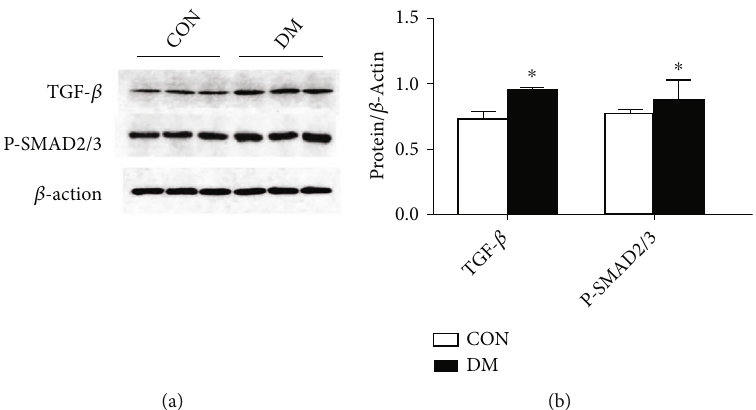
Figure 5: Expression of TGF- β and P-SMAD2/3 was analyzed by Western blots in kidney tissues from diabetic minipigs. (a) Detection of TGF- β and P-SMAD2/3 expression by Western blots. (b) Semiquantitative analysis of the expression levels of TGF- β and P-SMAD2/3. Protein expression data are presented as the means ± SD . ∗ P < 0 : 05 versus